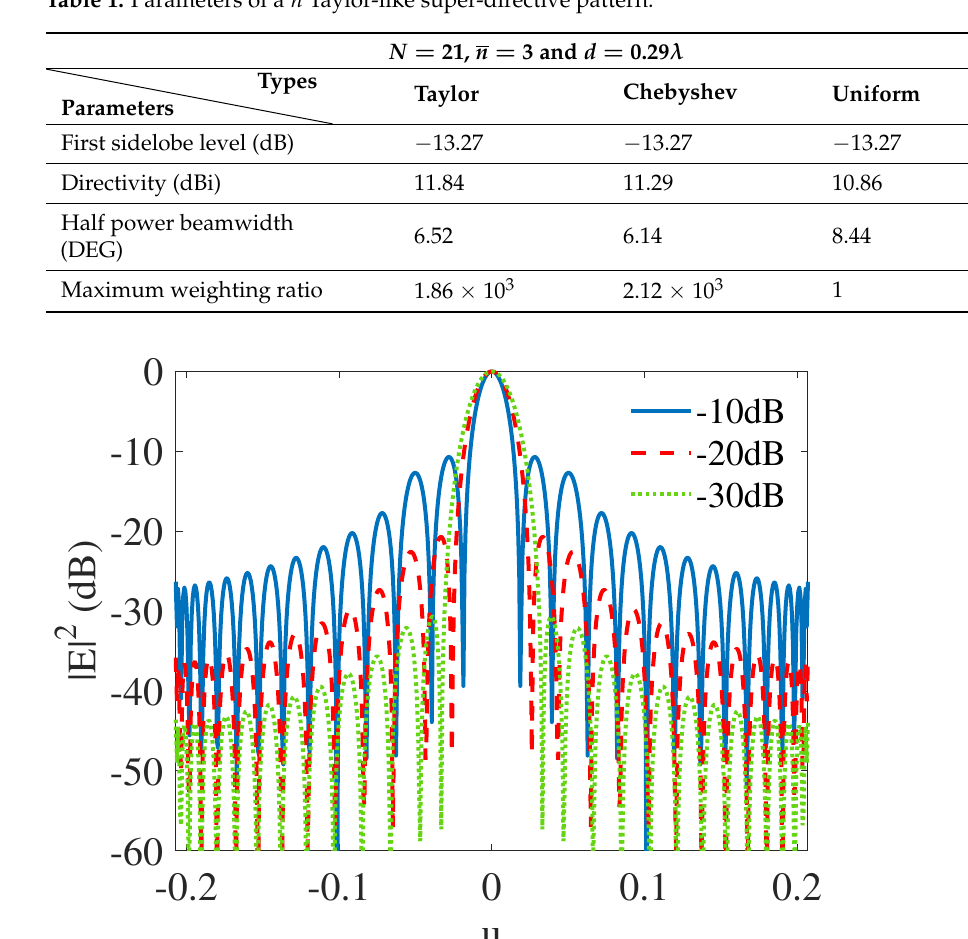
Figure 5. Comparison of Taylor-like super-directive patterns with different combinations of cosh π A and pattern ratios, where the blue line denotes a − 10 dB first sidelobe level when the pattern ratio is 4 dB and cosh π A = 6 dB, the red dashed line denotes a − 20 dB first sidelobe level when the pattern ratio is 12 dB and cosh π A = 8 dB, the green dotted line denotes a − 30 dB first sidelobe level when the pattern ratio is 15 dB and cosh π A = 15 dB. Table 2. Comparison of n Taylor-like super-directive patterns with different combinations of cosh π A and pattern ratios. d = 0.21 λ , n = 3 and N = 29 Pattern Ratio (dB) and cosh π